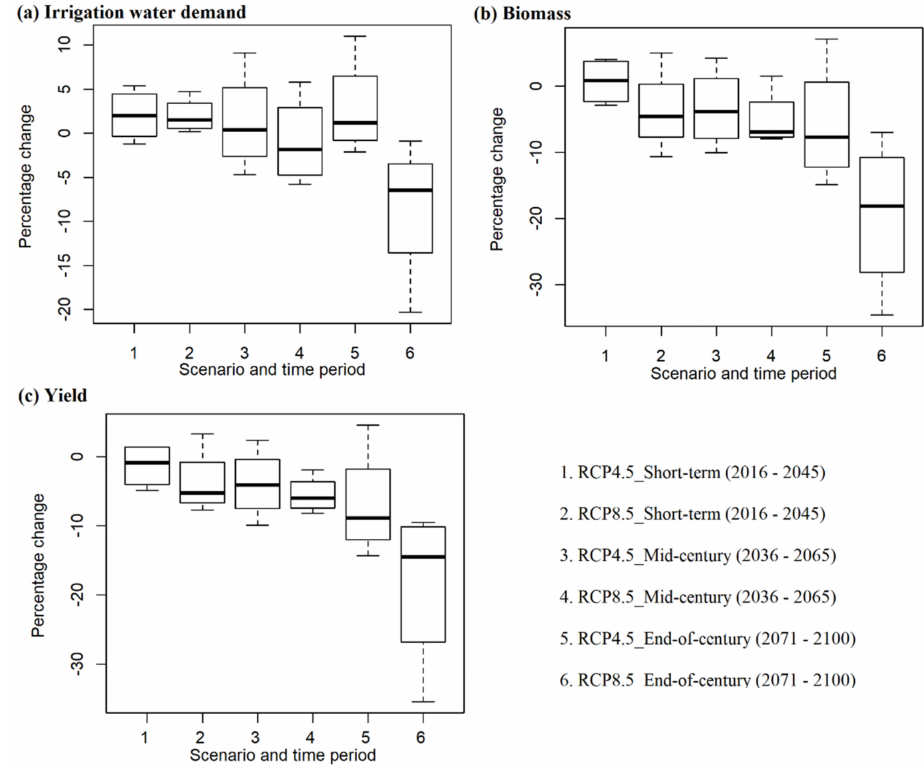
Figure 6. Variability in projected irrigation water demand, biomass, and yield compared with the reference period of 1981–2010. Boxplots show minimum, 25th percentile, median, 75th percentile, and the